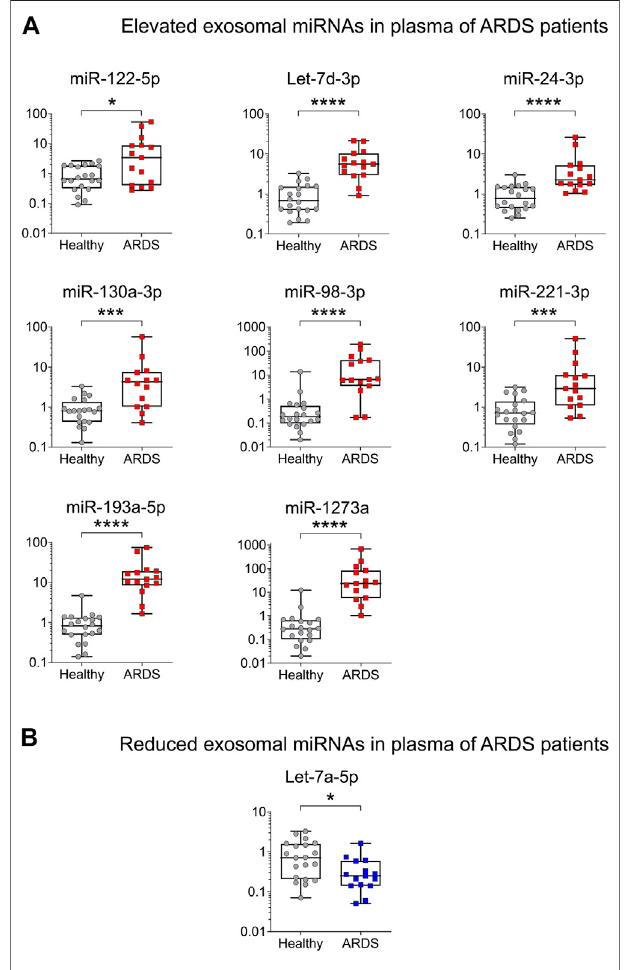
FIGURE 3 | Validation of ARDS-related miRNAs in an independent cohort by qRT-PCR. (A) High levels of plasma exosomal miRNAs in ARDS. miR-122-5p Fold change (FC) (cid:2) 5.17, Let-7d-3p FC (cid:2) 8.22, miR-24-3p FC (cid:2) 2.92, miR-130a-3pFC (cid:2) 5.28, miR-98-3p FC (cid:2) 5.28, miR-221-3p FC (cid:2) 4.10, miR-193a-5p FC (cid:2) 14.79 and miR-1273a FC (cid:2) 83.17. (B) Low levels of plasma exosomal miRNAs in ARDS. Let-7a-5p FC (cid:2) − 2.74. Data are non- normally distributed and analyzed using a non-parametric two-tailed Mann – Whitney test: * p < 0.05, ** p < 0.01, *** p < 0.001, and **** p < 0.0001. HS(graycircles) n (cid:2) 20biologicallyindependentsamples;ARDS(redsquares) n (cid:2) 15 biologically independent